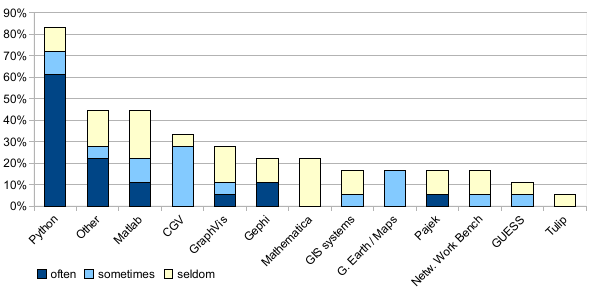
Figure 4. Tools used to visualise